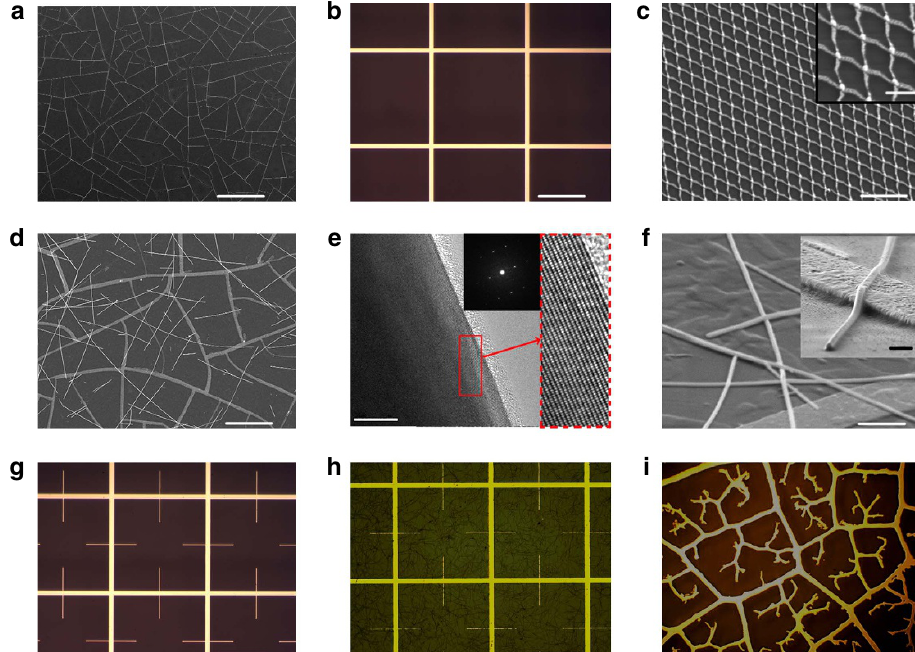
Figure 2 | Morphology of the model networks. Single-order networks: ( a ) C network (R1; SEM image; scale bar, 200 m m); ( b ) large-scale simple grid network (P1; optical image; scale bar, 200 m m); and ( c ) ultrafine scale grid network (UP1; SEM image; scale bar, 5 m m). Two-order random networks: ( d ) C-based network (R2; SEM image; scale bar, 30 m m). ( e ) High (atomic)-resolution transmission electron microscopy images of a single NW. Inset shows an X-ray diffraction pattern. Scale bar, 10nm. ( f ) High-resolution SEM image of the R2 network at the tilt angle of B 60 (cid:2) . Scale bar, 2 m m. Inset: details of the ribbon–NW contact (scale bar, 400nm). ( g ) Two-order periodic network (P2; optical image; scale bar, 200 m m). ( h ) Three-order periodic network (M3) obtained by adding NW to the P2 network. Scale bar, 200 m m. ( i ) Optical image of the quasi fractal QF network. Scale bar, 500 m